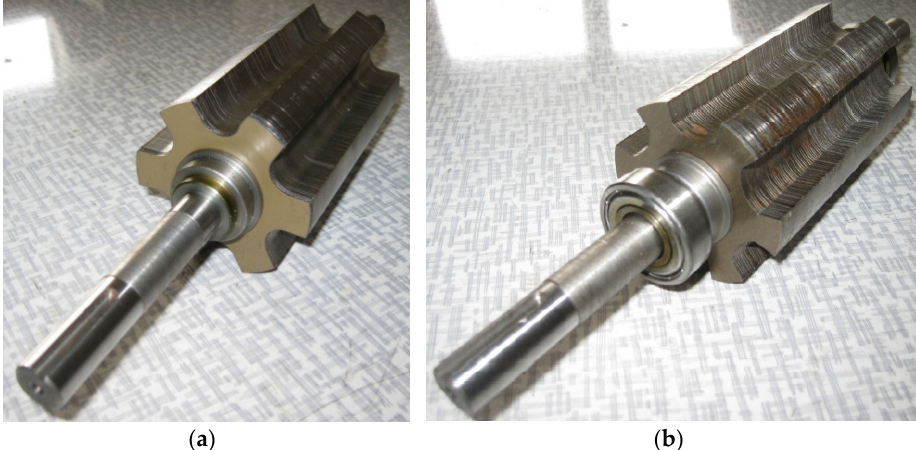
Figure 8. The appearance of the tested 8/6 symmetrical switched reluctance motors rotors: ( a ) straight poles; ( b ) oblique poles.